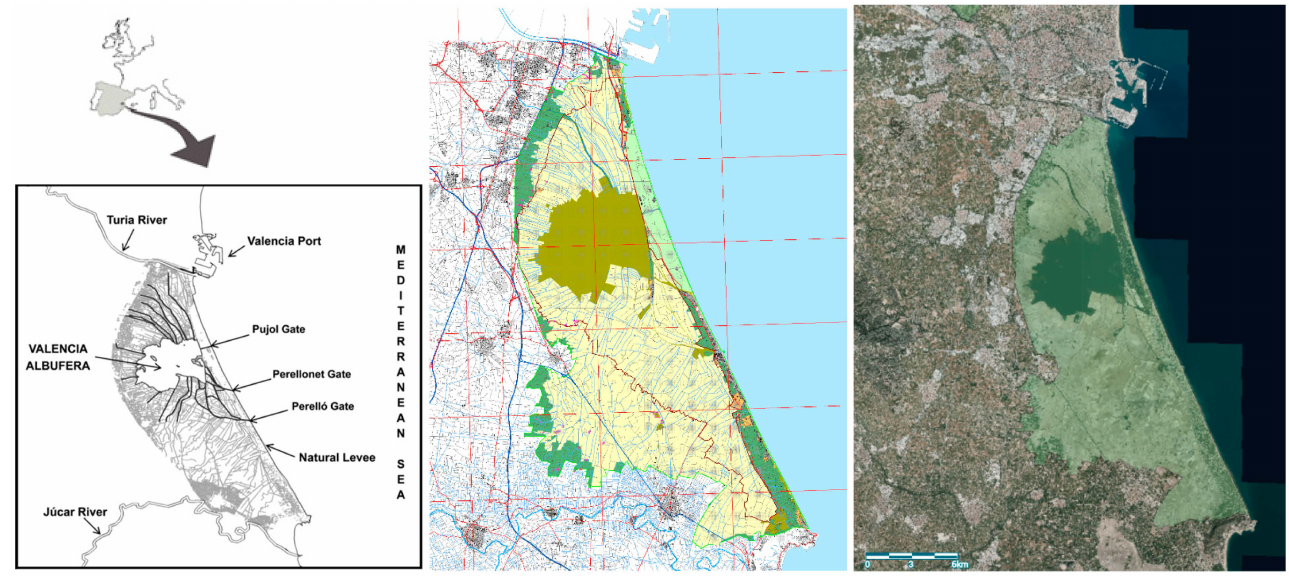
Figure 5. The Albufera of Valencia Natural Park: situation and boundary